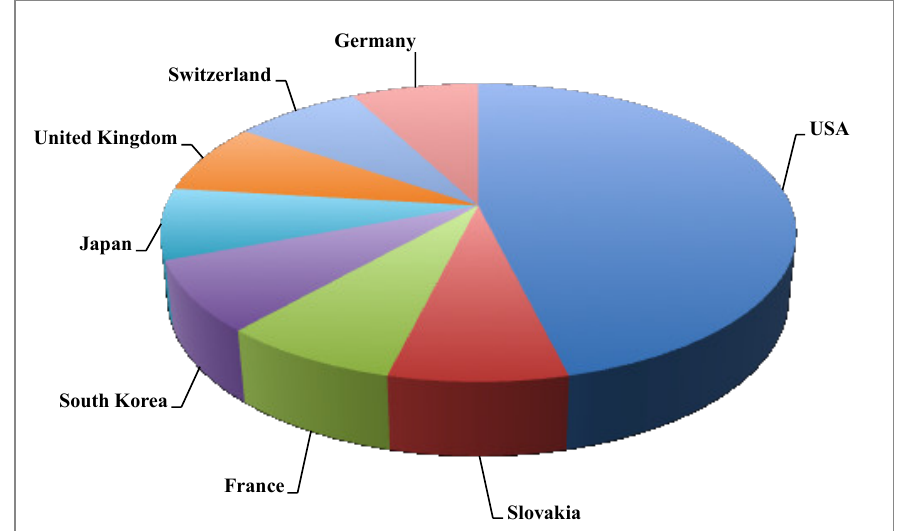
Figure 1. Distribution of global microbial biosurfactant producers by countries based on the number of companies.